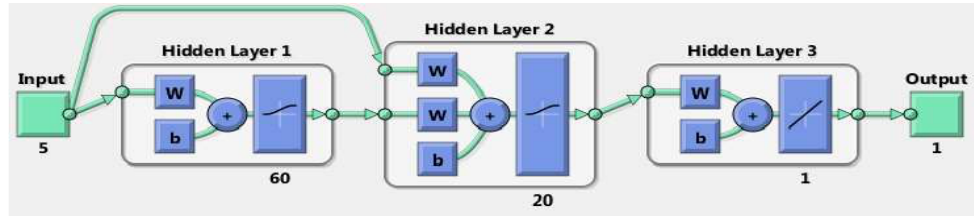
Figure 11. Torque neural network topology.